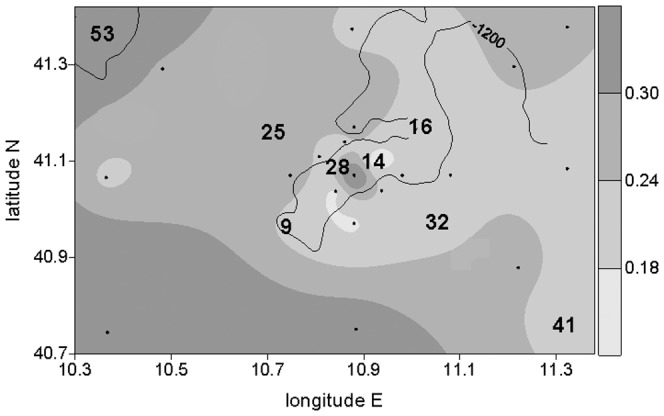
Seawater autotrophic pigment distribution.Chlorophyll-a concentrations (µg l−1) in the water column have been averaged for the 0–120 m layer. The numbers indicate the stations also sampled for the sedimentary parameters, the dots indicate all the stations sampled for the autotrophic biomass determination in the water column. The line reports the 1200 m depth isobath.